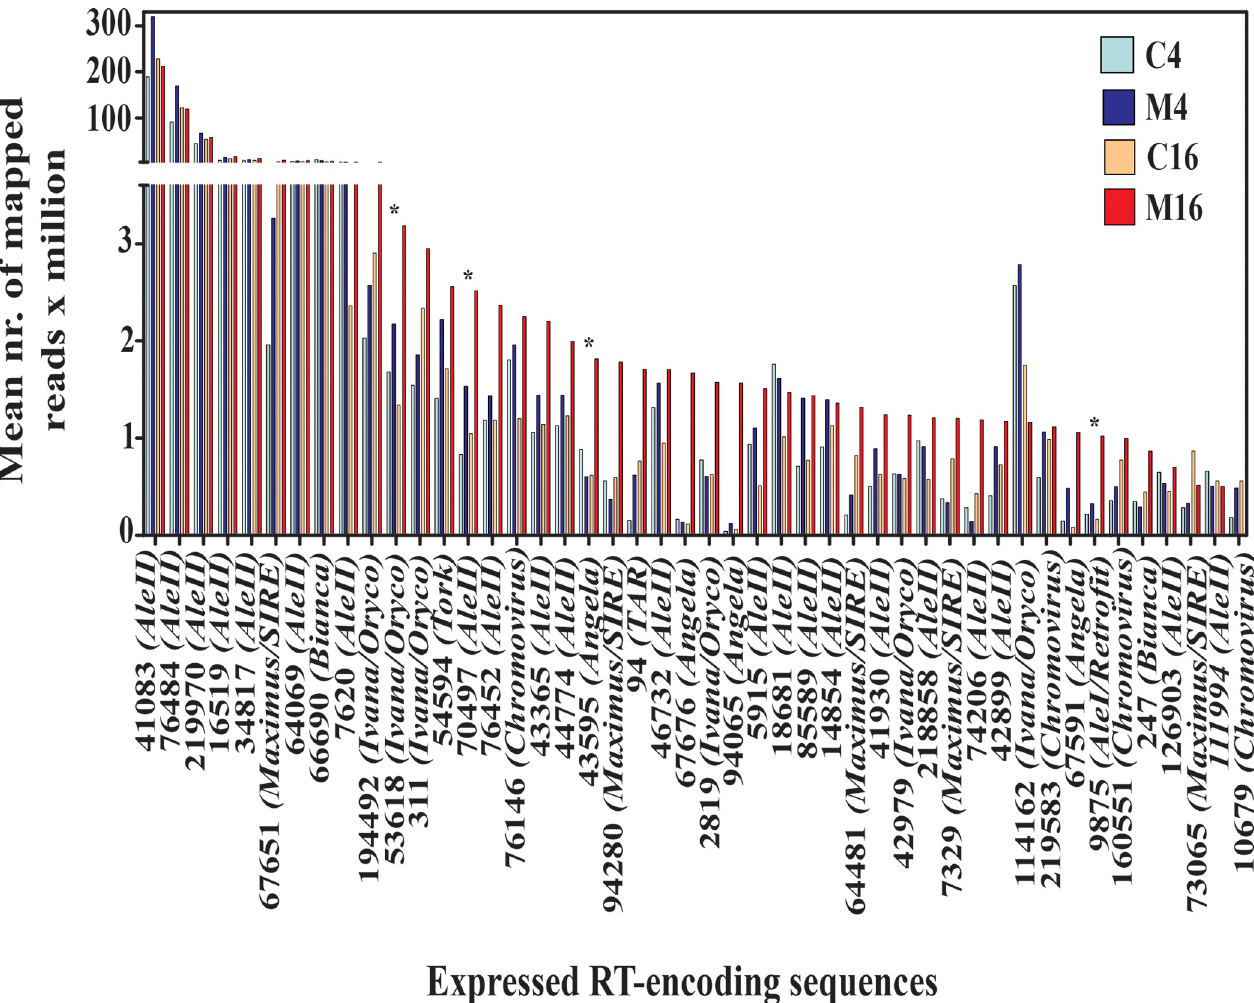
Fig 4. Mapped reads per million of 46 expressed (more than one mapped read x million in at least one cDNA Illumina library) reverse transcriptase (RT)-encoding sequences in Helianthus annuus mycorrhizal (M) and control roots (C) after culture for 4 and 16 days. Asterisks indicate significant over- expressed RT sequences (at day